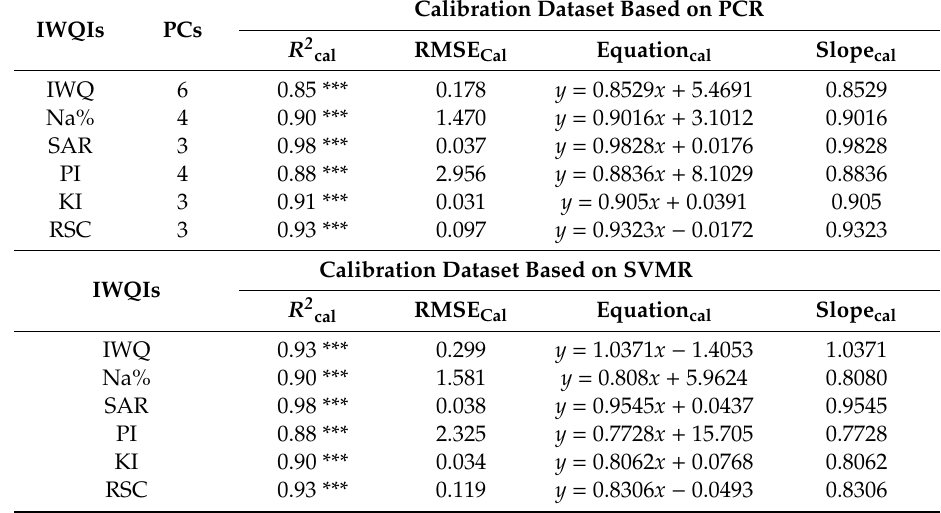
Table 6. Coe ffi cient of determination ( R 2 ), root mean squared error (RMSE), and slope and equations for calibration ( R 2 cal , RMSE Cal , slope cal and Equation cal ) statistics of the PCR and SVMR models for the (IWQIs). ***: p < 0.001. Calibration Dataset Based on PCR IWQIs PCs R 2 cal RMSE Cal Equation cal